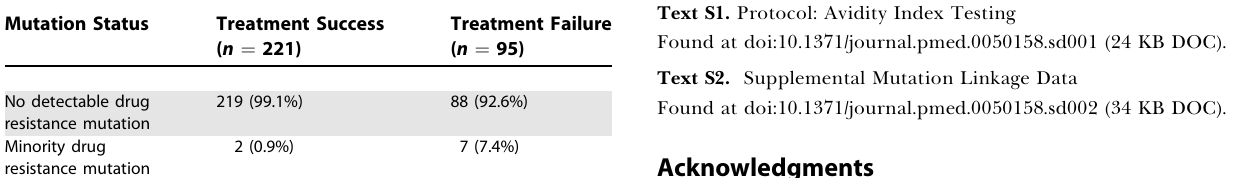
Table 6. Fraction of Treatment Success or Failure Versus the Presence of Detectable Minority Drug Resistance Mutations for the 316 Treatment Study Participants Evaluated (Fisher exact test, p ¼ 0.0038)